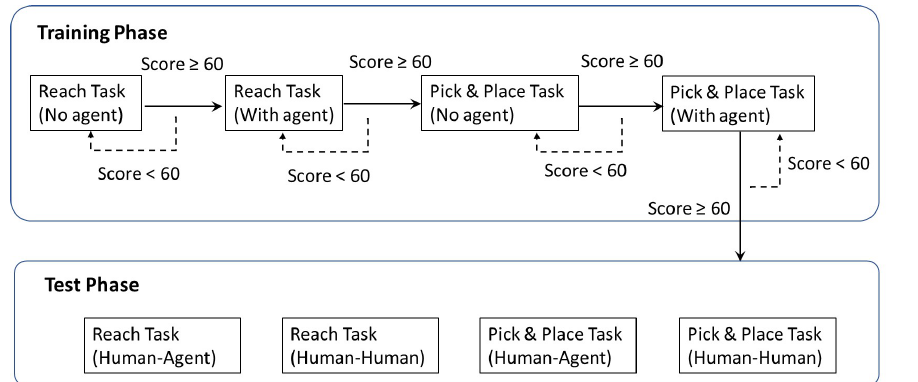
Figure 7. Experiment procedure overview.